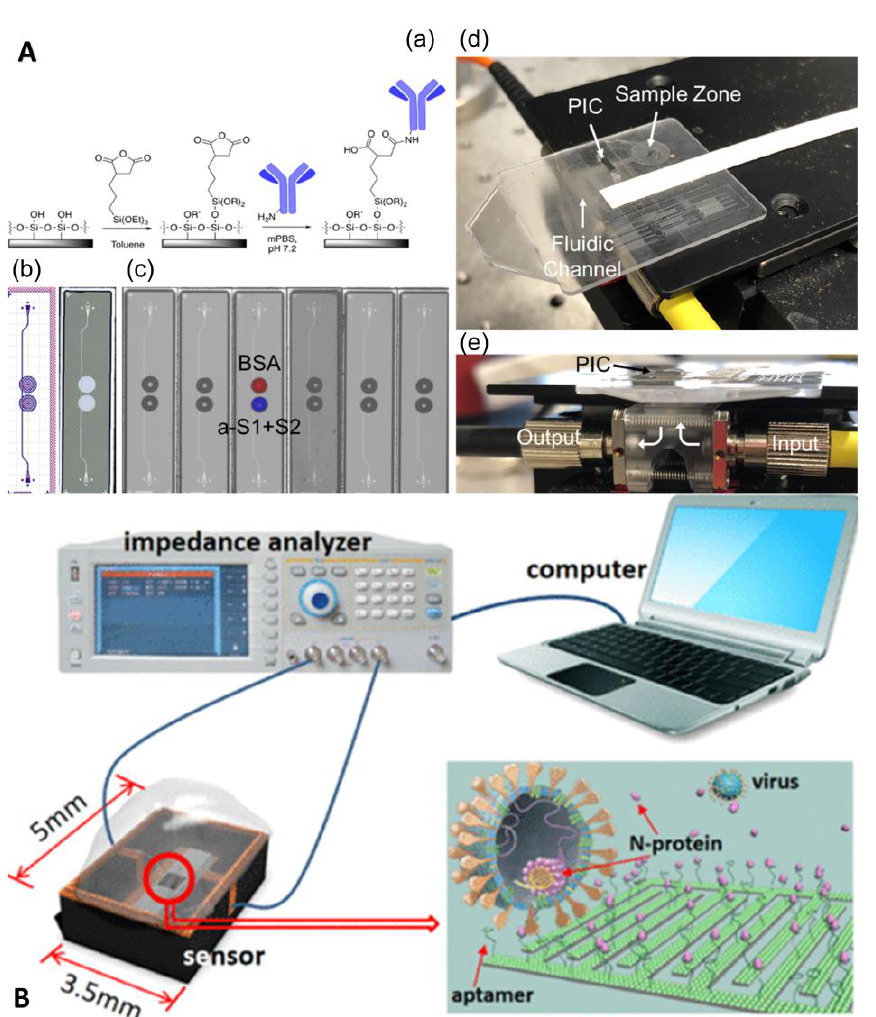
Figure 11. Microfluidic laboratory based on unlabeled Immunoassay. ( A ) Disposable photonic assay platform: ( a ) functionalization schematic, ( b ) GDS (graphic design system) and laser confocal image, ( c ) image of antibody/antigen solutions spotted on chips, ( d ) image of the full microfluidic/photonic chip assembly, and ( e ) sideview of the custom optical hub. Reproduced with permission from Cognetti, J. S., Sensors , published by MDPI, 2021 [82]. ( B ) Conceptual illustration of the sensor, mea- surement system, and N-protein capturing. Reproduced with permission from Qi, H., Anal. Chem. , published by American Chemistry Society, 2022